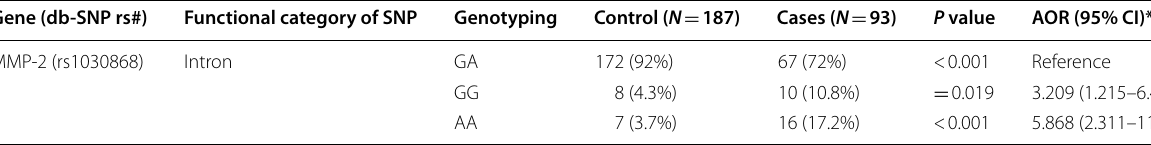
N number, % percentage, G guanine base, A adenine base Significant association ( p < 0.05)